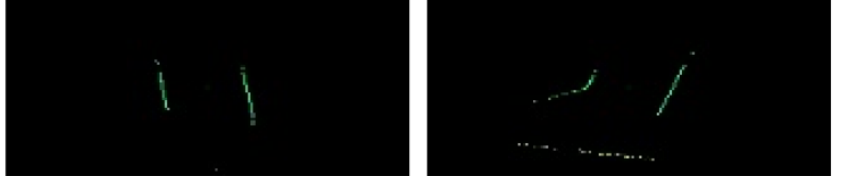
Figure 19. Examples of images collected from the LiDAR. Point clouds are projected into a bird-eye view 2D